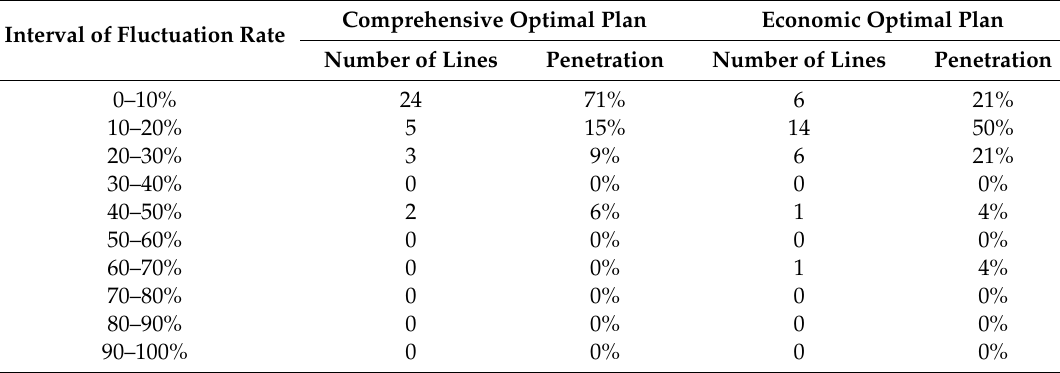
Table 5. Distribution of line power fluctuation rate.